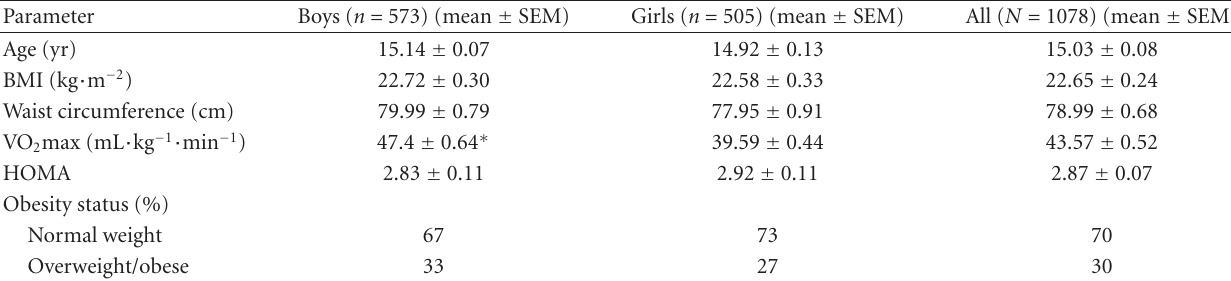
Table 1: Characteristics of the study sample by gender.